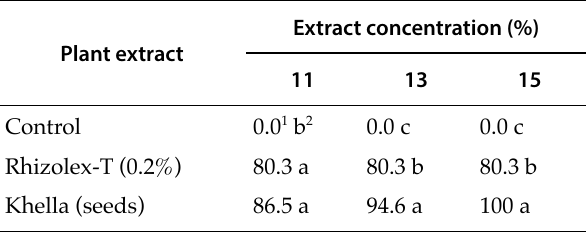
1 Each value represents the mean of three replicates. 2 Values within each column followed by the same letter(s) are not significantly different ( P ≤0.05) according to Duncan’s multiple range